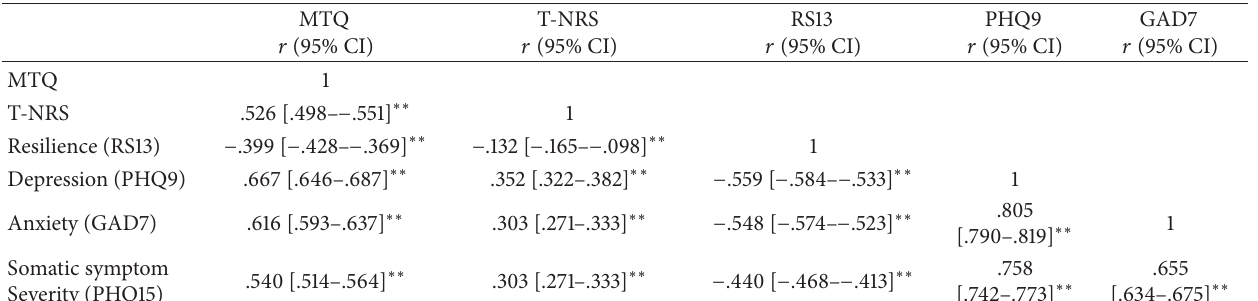
Table 2: Bivariate